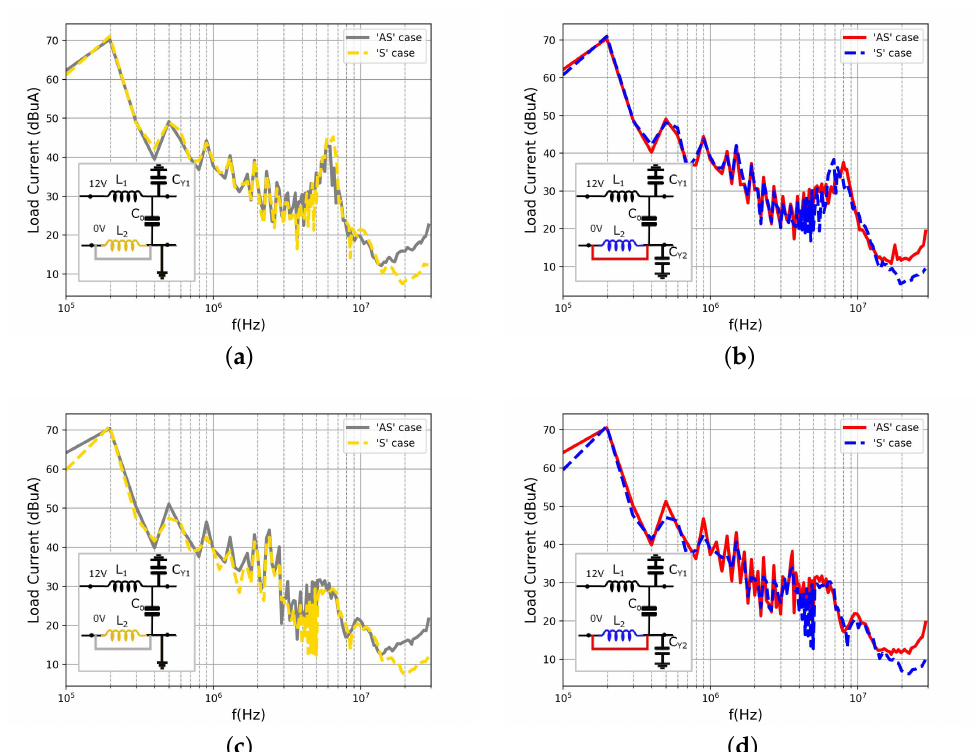
Figure 8. Measured DM output currents for symmetric (‘S’) and asymmetric (‘AS’) cases. ( a ) C y = 10 nF. ‘C0VG’ configuration. ( b ) C y = 10 nF. ‘CC’ configuration. ( c ) C y = 50 nF. ‘C0VG’ configuration. ( d ) C y = 50 nF. ‘CC’